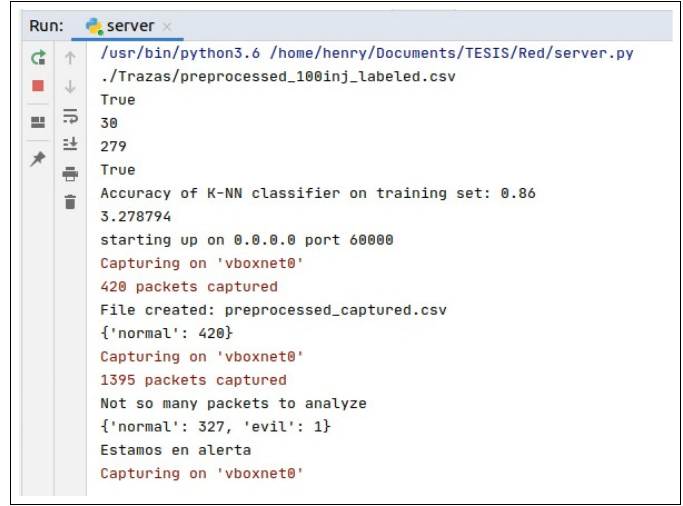
Figure 9. Machine Learning Injection attack